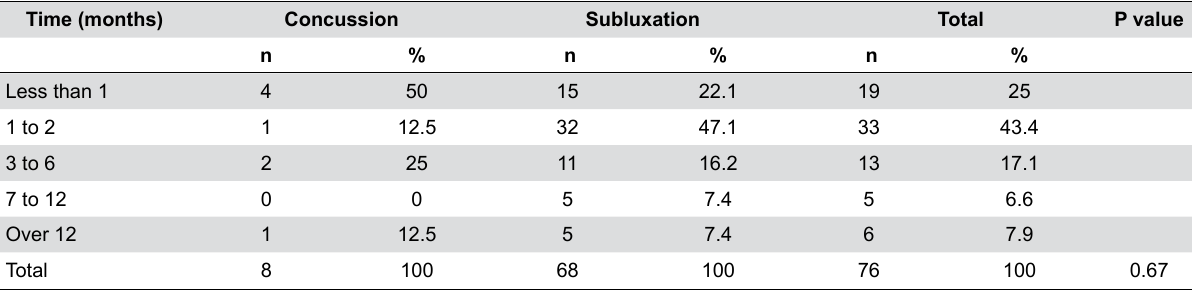
Table 5- Time between the injury and the diagnosis of pulp necrosis